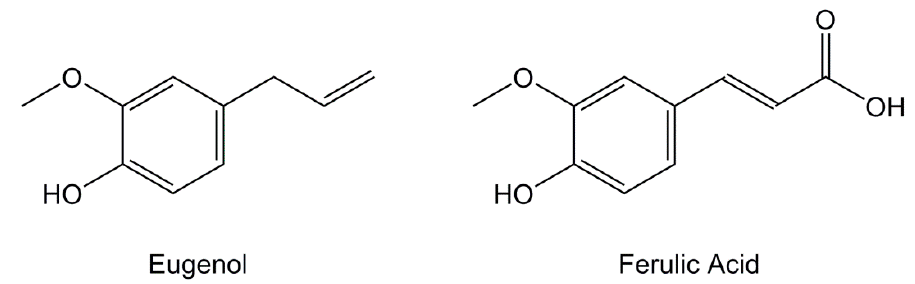
Figure 10. Structures of eugenol and ferulic acid.